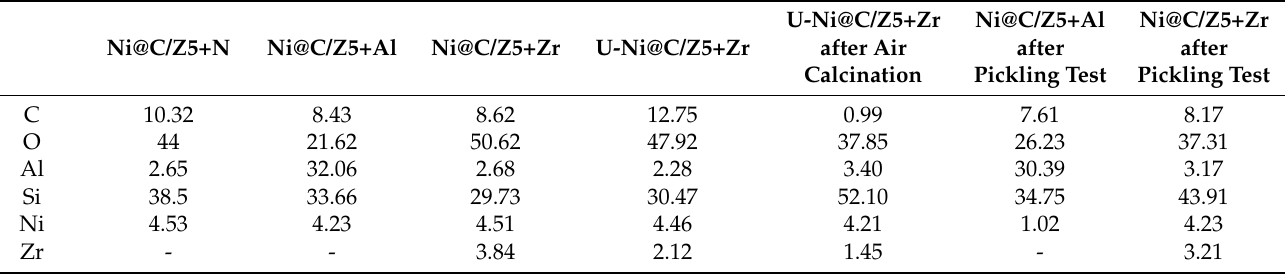
Table 1. EDS of the shaped